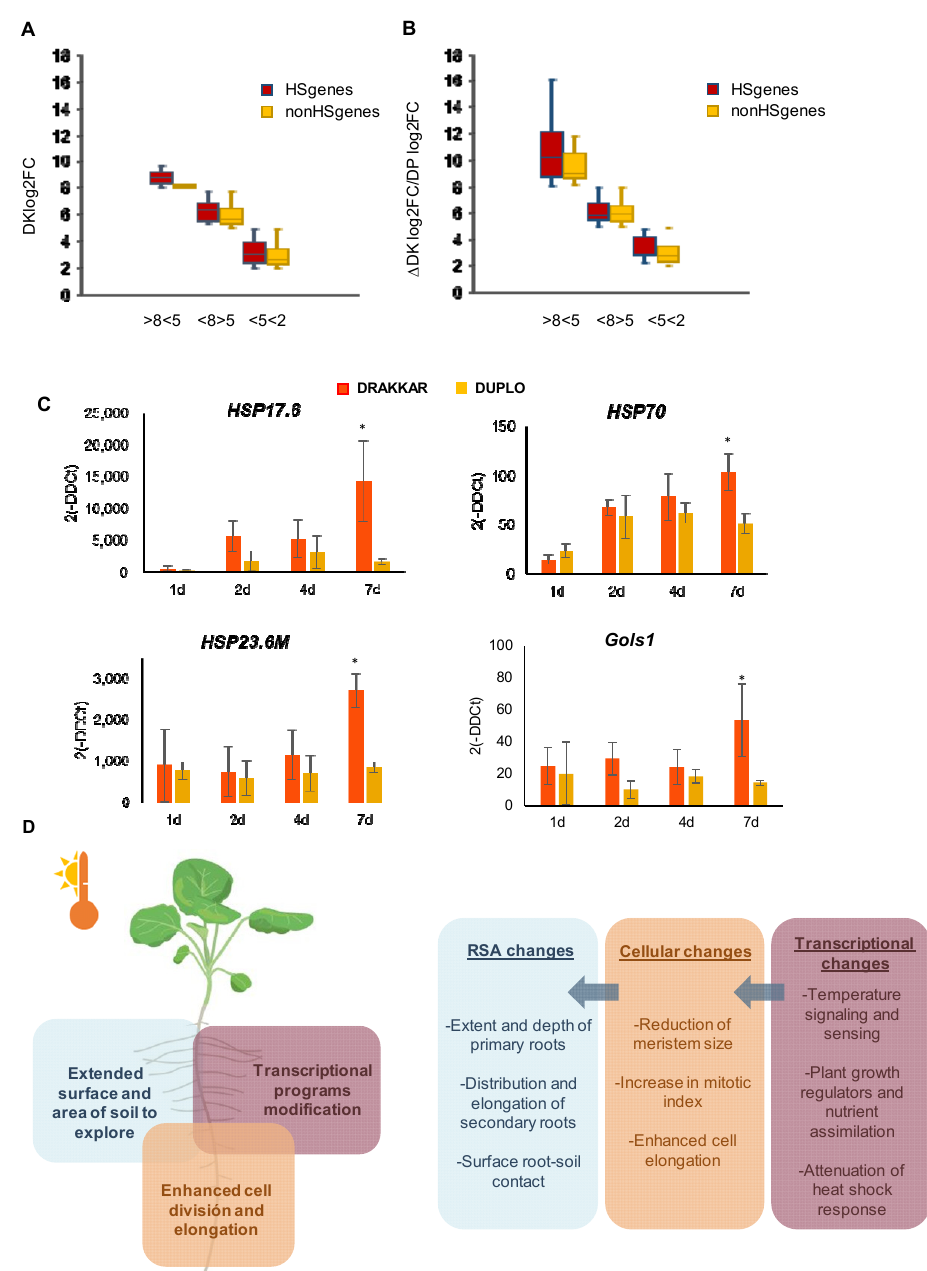
Figure 7. Attenuation of heat-shock stress response is crucial to adjusting root response. ( A ) Com- parison between fold change values of heat-shock (HS) response genes and non-heat-shock (nHS) response genes of Drakkar DEGs, showing that this group of HSR genes had the highest fold changes of Drakkar DEGs. x -axis represents three consecutive intervals of DK log2FC values (DK, Drakkar). Red boxes correspond to HS genes, whereas yellow boxes correspond to nHS genes. ( B ) Differences between Drakkar log2FC and Duplo log2FC of HS response genes and nHS response genes, showing the highest differences between Drakkar log2FC and Duplo log2FC. X -axis represents three consecutive intervals of ∆ DK log2FC/DP log2FC values (DP, Duplo). Red boxes correspond to HS genes, whereas yellow boxes correspond to nHS genes. ( C ) Differential dynamics of heat-shock response gene expression ( BnHSP17.6 , BnHSP70 , BnHSP23.6M , and BnGols1 ) at 24 h, 48 h, 4 days, and 7 days after being exposed to 29 °C compared to control temperature, 21 °C, in Drakkar and Duplo roots. Statistical t-test analysis of three biological replicates * p < 0.05. ( D ) Warm temperature-triggered changes of several root traits promote root response by facilitating roots’ ac- cess to extended areas of soil (blue square box). Enhanced cell division and elongation support this